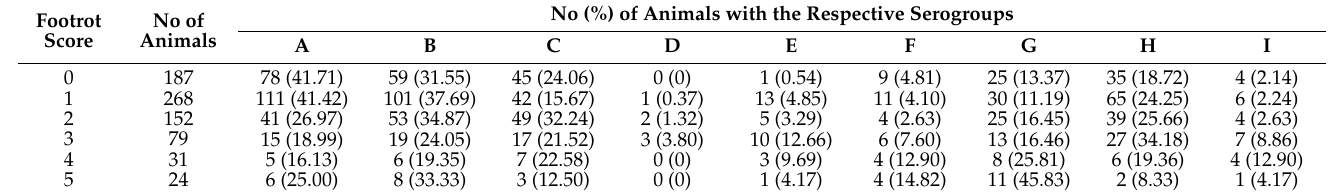
Table 5. Distribution of serogroups by animals and footrot scores. Number (No) and percentage of animals with the respective serogroups. The percentages refer to the number of animals with serogroups detected and footrot scores.